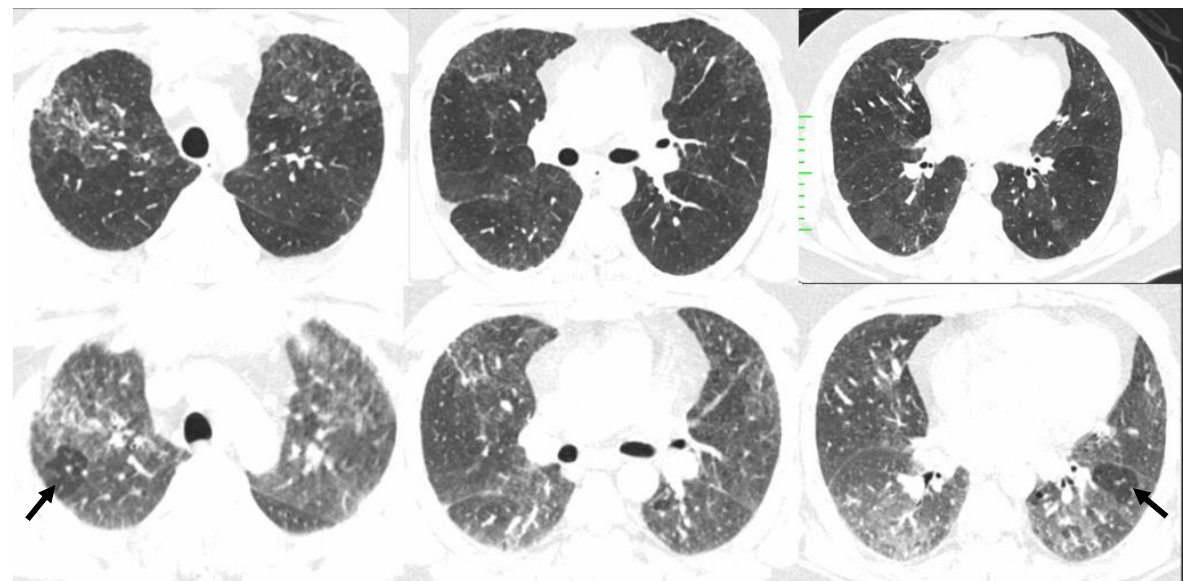
Figure 10. Compatible with fibrotic HP. Axial and coronal expiratory phase CT ( A , B ) shows coarse reticulations and minimal traction bronchiectasis superimposed on extensive upper lung predomi- nant GGOs with peribronchovascular and subpleural distribution. Air trapping (arrows) is evident.